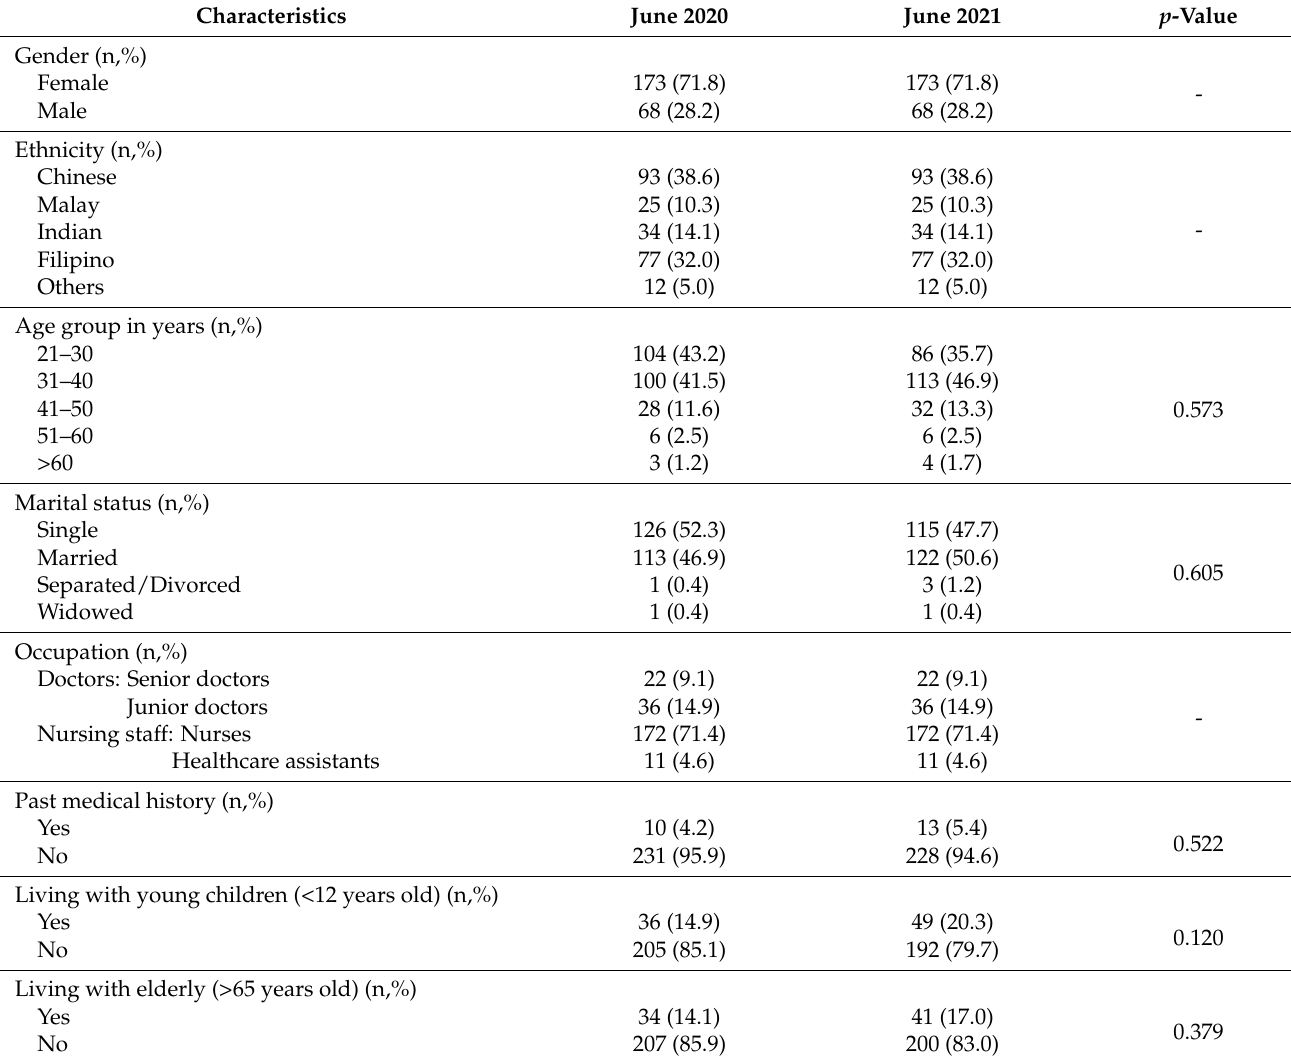
Table 1. Characteristics of matched participants (n = 241) in 2020 and 2021. There were 58 doctors (24.1%) and 183 nursing staff (75.9%) in each year’s